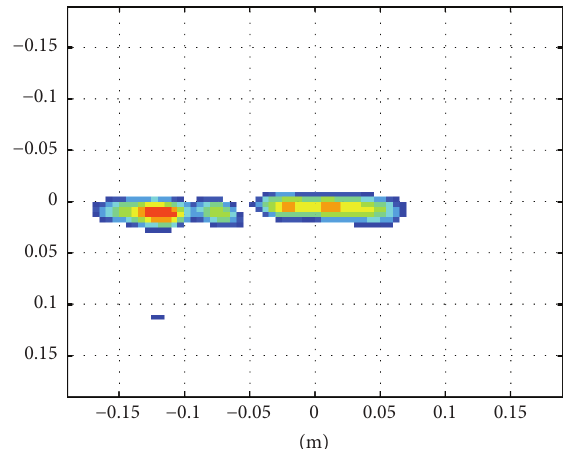
Figure 7: Ceramic/metal knife under coat